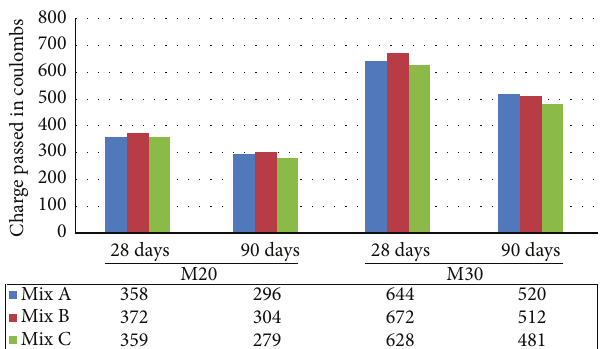
Figure 12: Comparative Rapid Chloride Permeability Test of Mix A, Mix B, and Mix C of M20 and M30